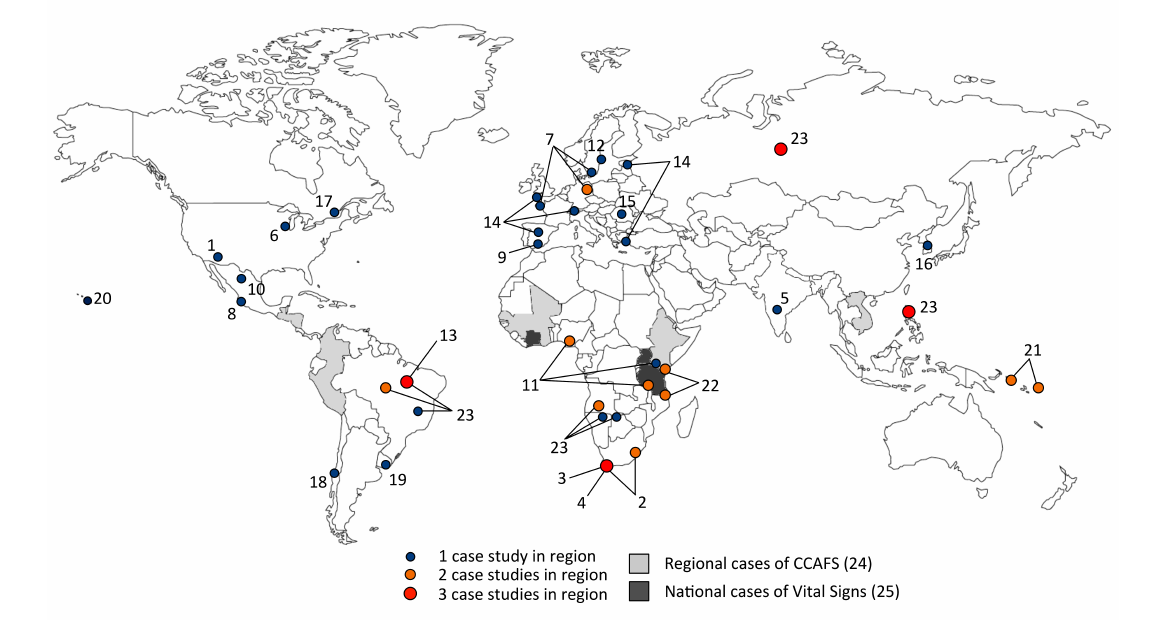
Fig. 2. Map of the locations of case studies included in our analysis. See Table 1 for individual project